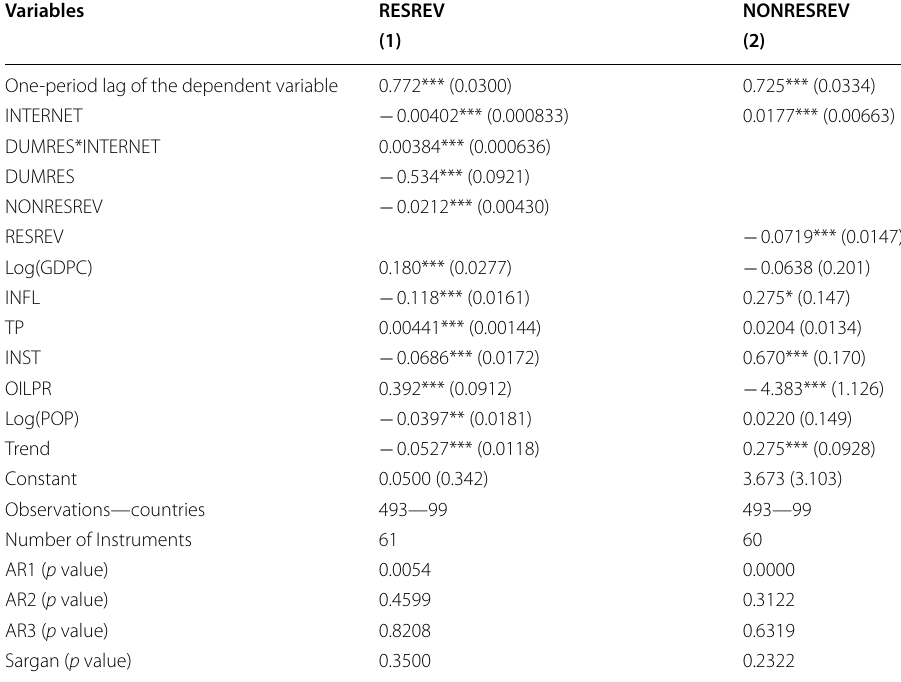
Table 3 Impact of the Internet on the share of resource revenue (% GDP) and the share of non-resource revenue (% GDP) over full sample. Estimator : Two-step system